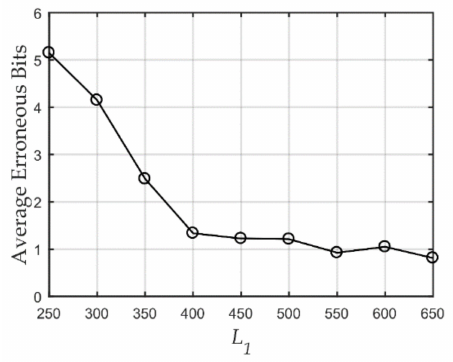
Figure 14. Average erroneous bits with different L 1